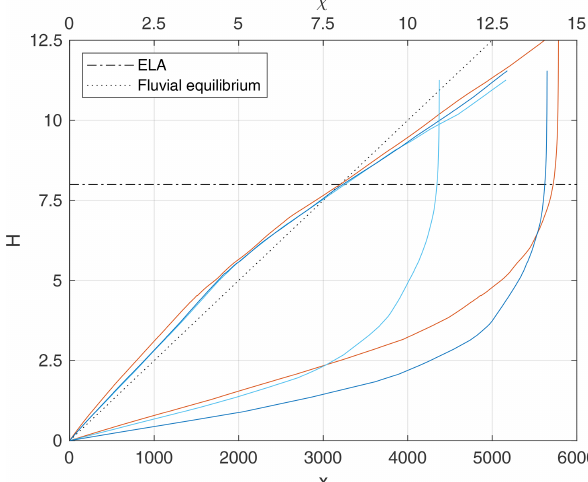
Figure 11. Longitudinal profiles of the largest flow paths, which are basically the same as in the fluvial topography in map view (Fig. 3). The lower set of lines refers to the original longitudinal coordinate x , while the upper set of lines depicts the χ -transformed